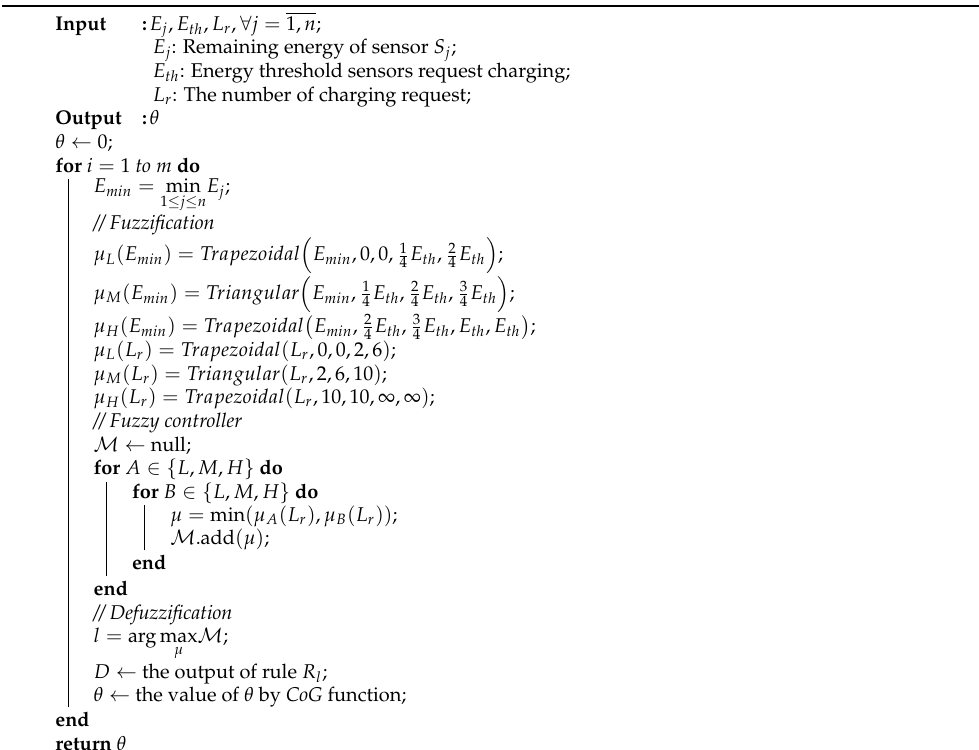
Algorithm 1: Fuzzy Logic-based θ